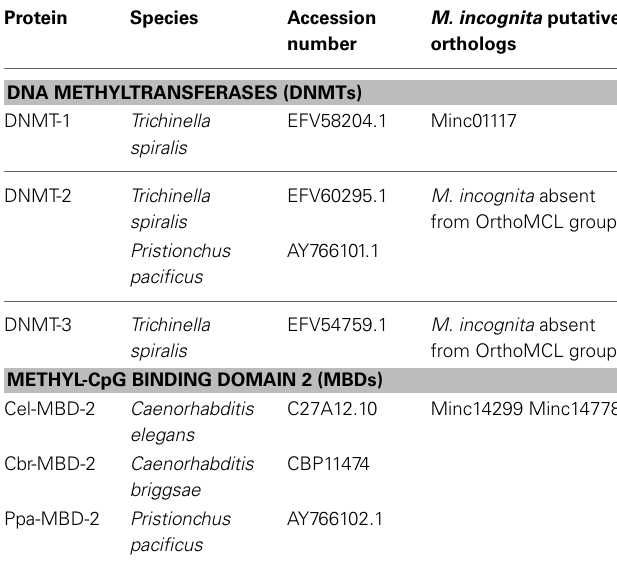
Table 1 | M. incognita putative orthologs for methyltransferases (DNMTs) and methyl-CpG binding domain (MBDs) proteins.